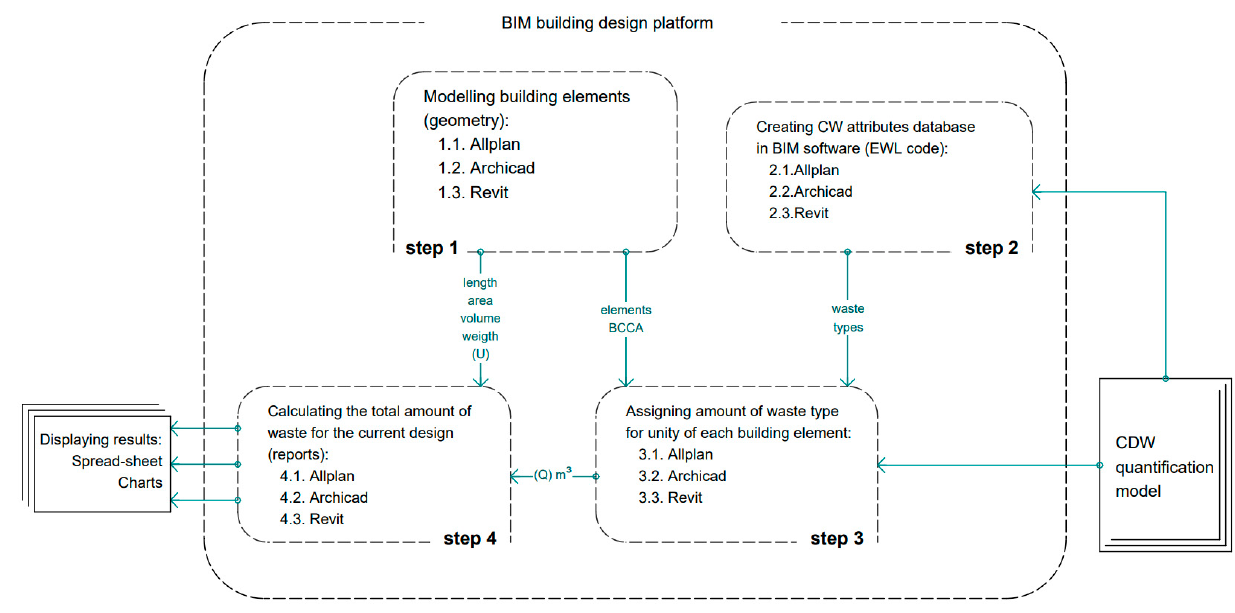
Figure 1. Flowchart of the developed methodology.